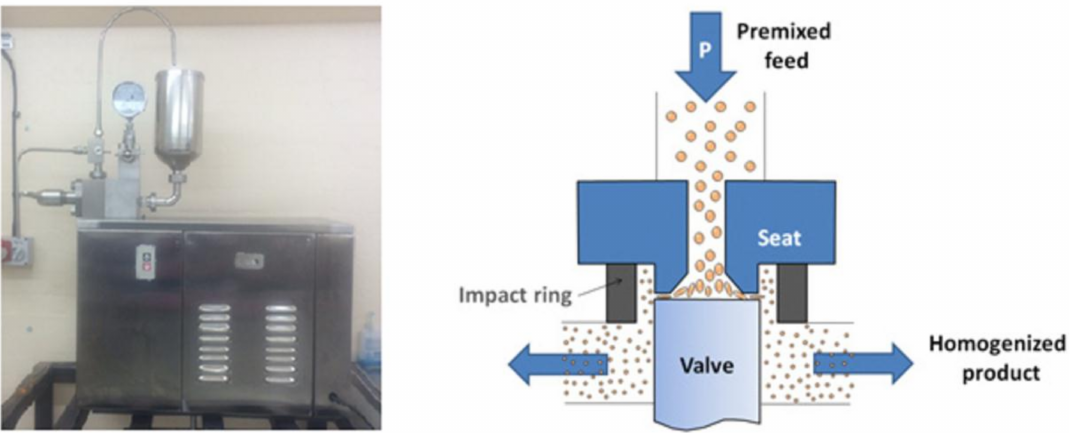
Figure 8. High-Pressure Homogenizer (HPH) used in this study ( left ), Operational performance of high-pressure homogenizer ( right